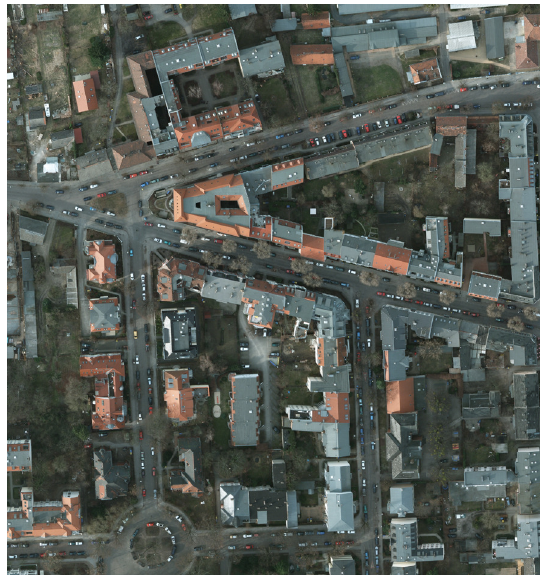
Figure 4: Digital Ortho Photo DOP based on Ultracam images of the orientation test bed